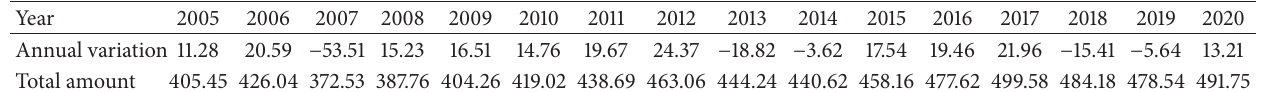
Table 4: The amount of pig breeding from 2005 to 2020 (ten thousand headage).